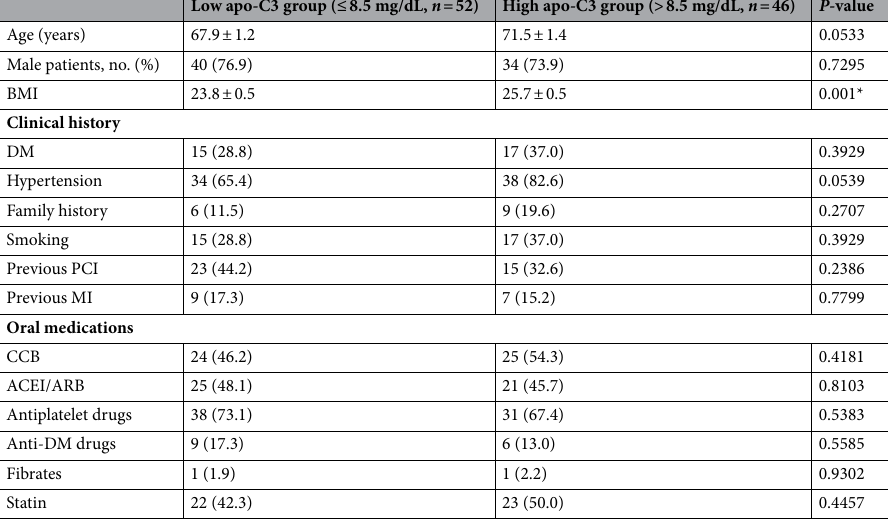
Table 1. Comparisons of clinical characteristics and oral medications between the low and high apo-C3 groups. Values are presented as mean ± standard errors or as numbers (percentages) of patients. * P < 0.05. apo-